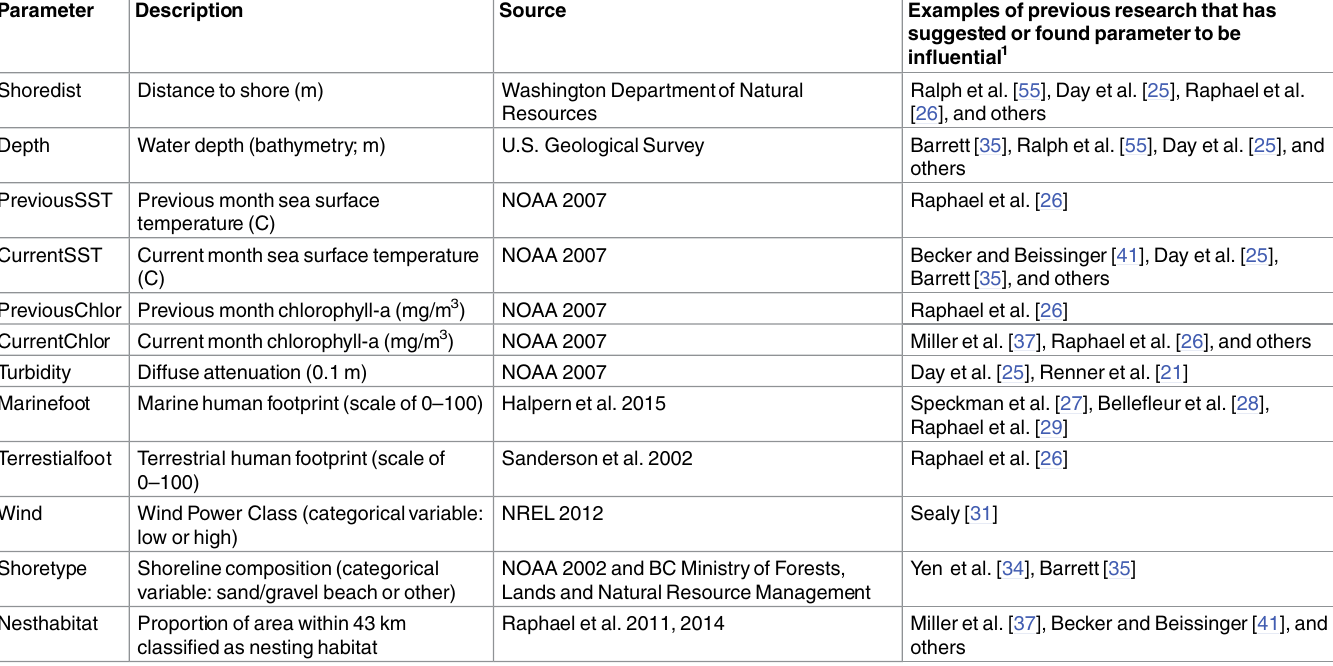
Table 1. Description of parameters consideredfor examiningmarinehabitatselectionby marbledmurreletsin northwestern Washington,USA,